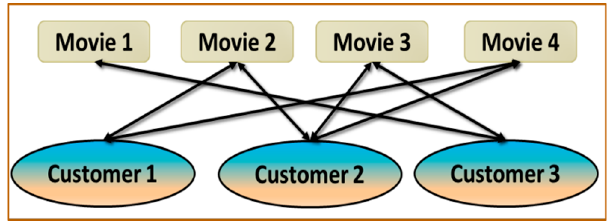
Figure 37. Example of the bipartite graph between customers and movies.